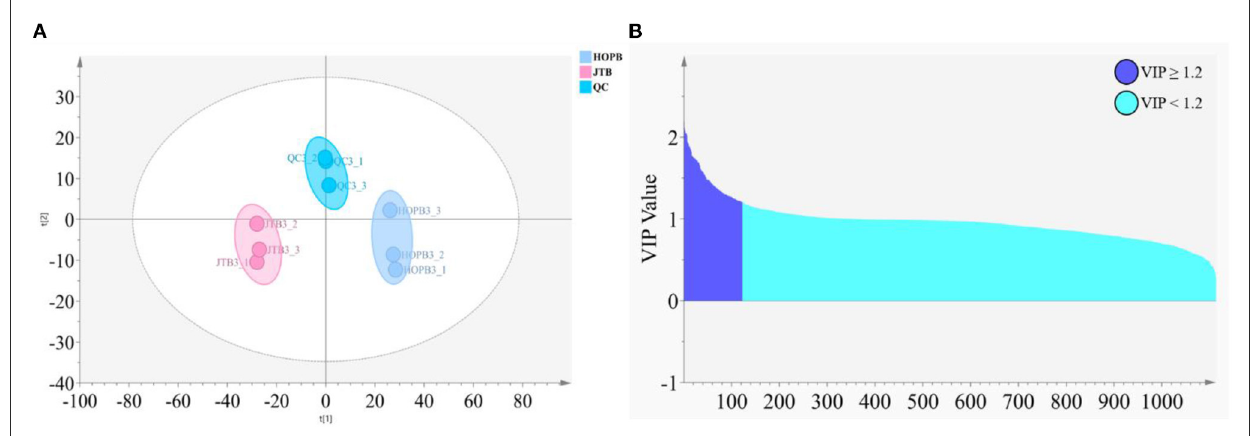
FIGURE4 Analysis of differential metabolites in different beers. (A) PCA score plot; (B) PLS-DA S-plot of HOPB vs. JTB (purple: VIP ≥ 1.2, blue: VIP <